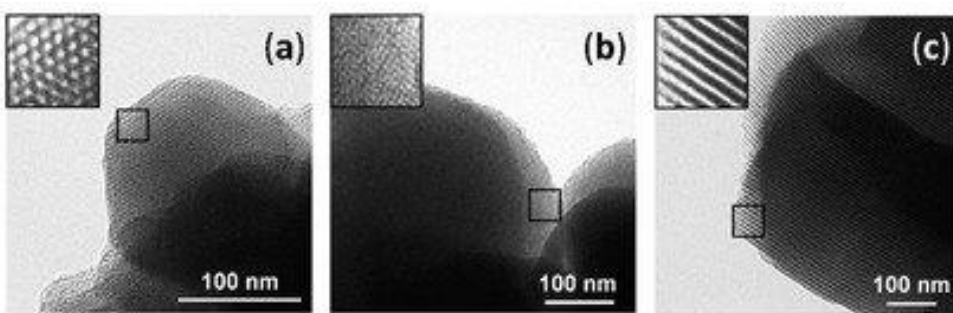
Figure 1. Transmission electron microscopy (TEM) images for calcined Mobil Crystalline Materials or Mobil Composition of Matter (MCM)-41 ( a ), MCM-48 ( b ), and Santa Barbara amorphous (SBA)-15 ( c ). Reprinted from an open access source [40].